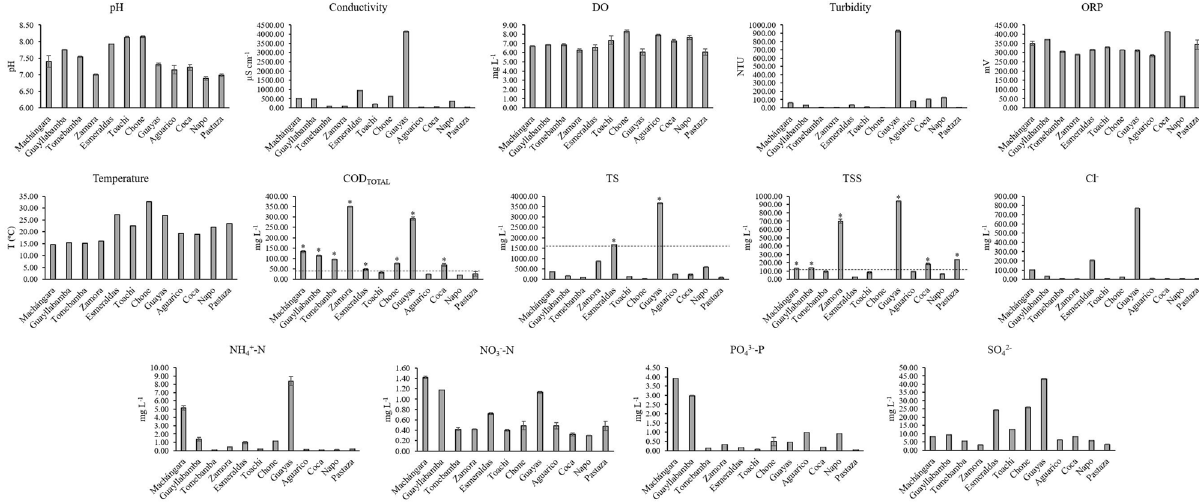
Figure 2. Average and standard deviation values of physicochemical parameters quantified in water samples of the twelve rivers in this study. Legend: Threshold of a certain physicochemical parameter (-—-); * exceedance values according to